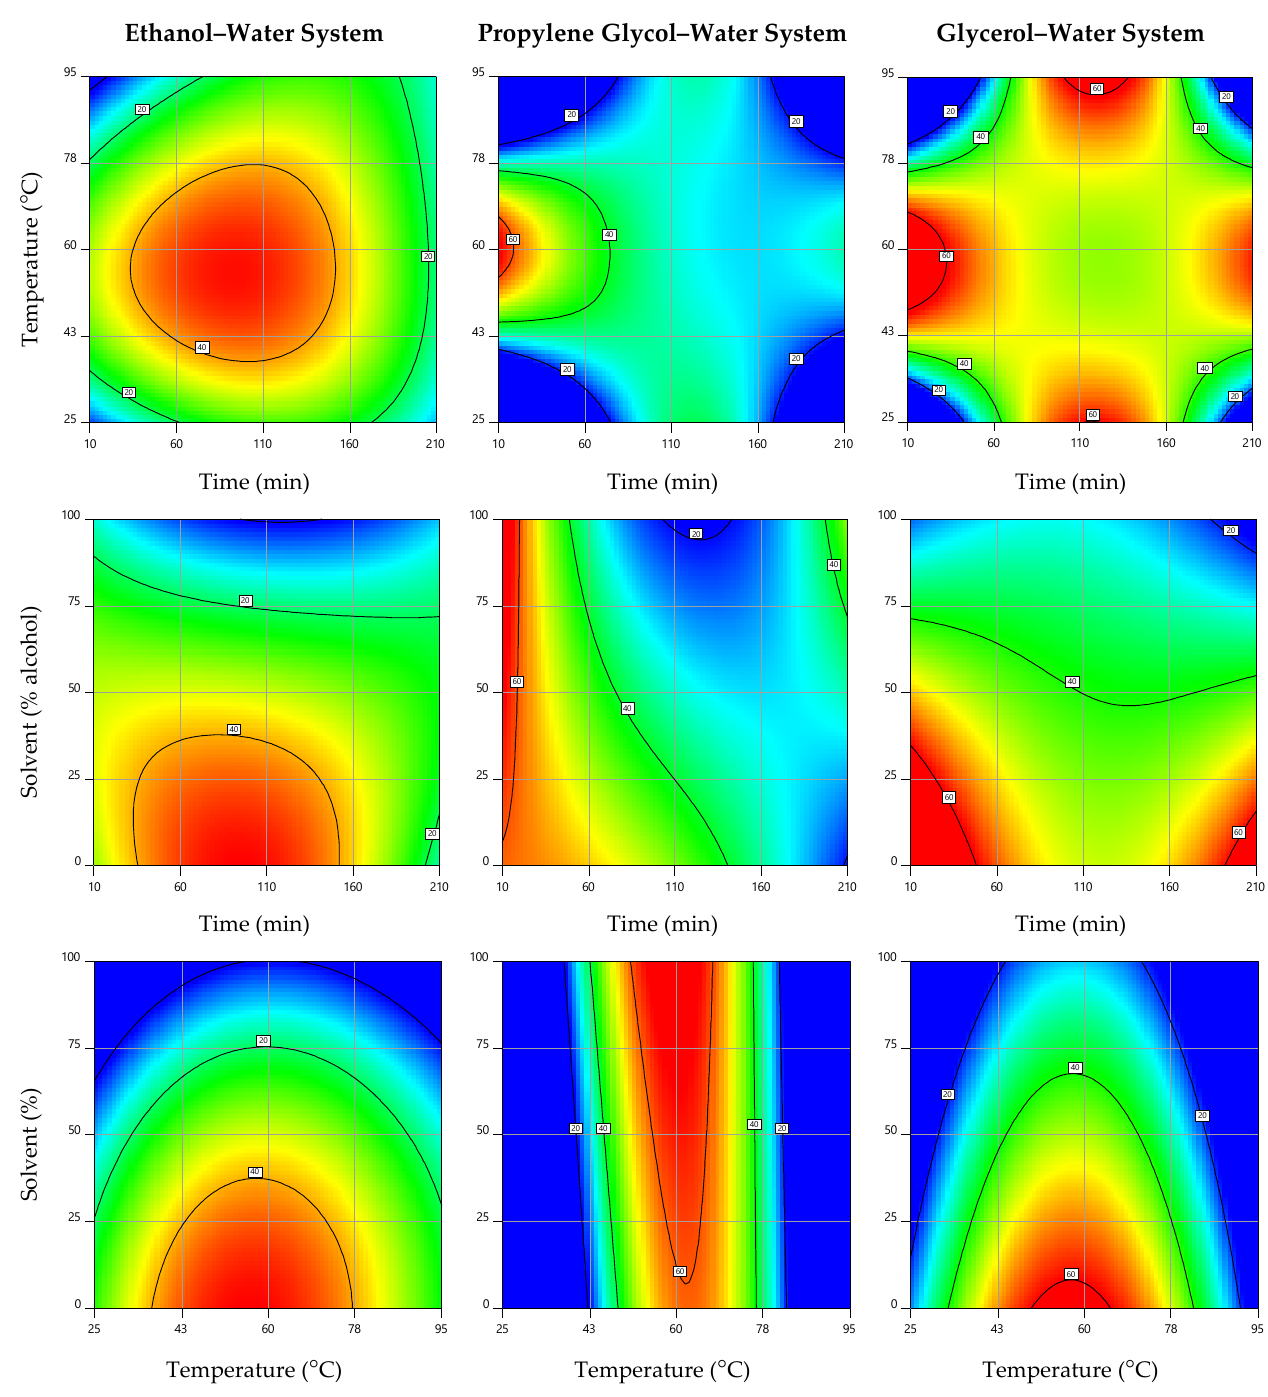
Figure 2. Contour plots showing the effects of the independent variables on the extraction of aloesin from Aloe vera rind as a function of the alcohol–water system. In each plot, the excluded variable was positioned at its optimal value (Table 2).